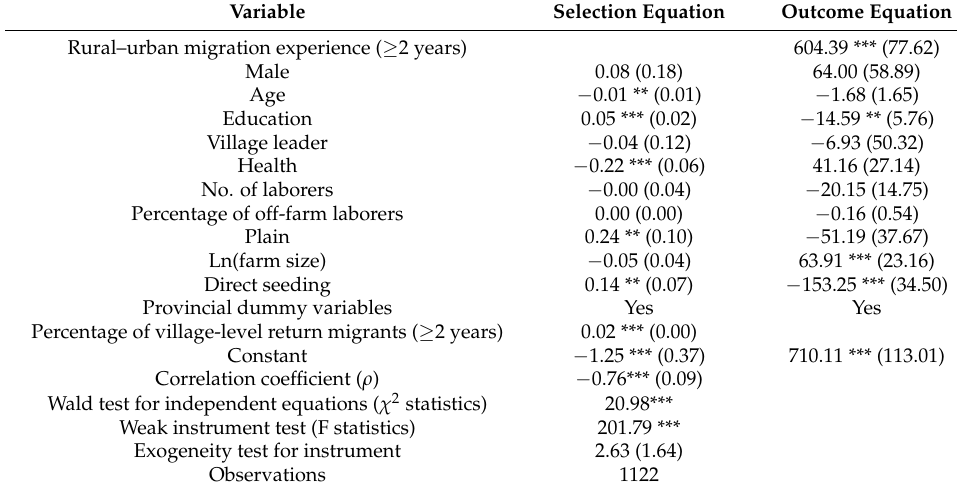
Table 3. Results of the robustness